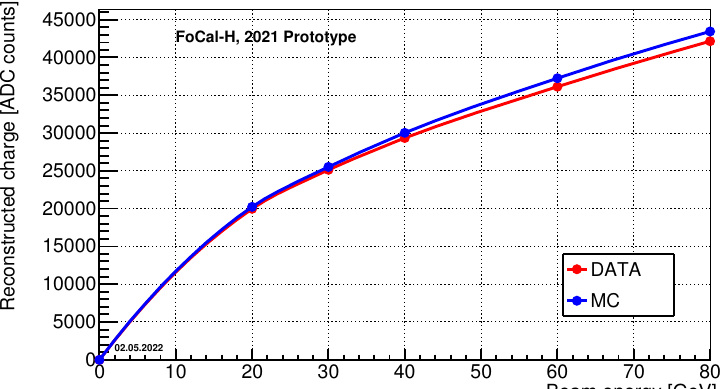
Figure 6. Dependence of the reconstructed electron charge (peak value) in ADC counts on beam particle energies from 20 to 80